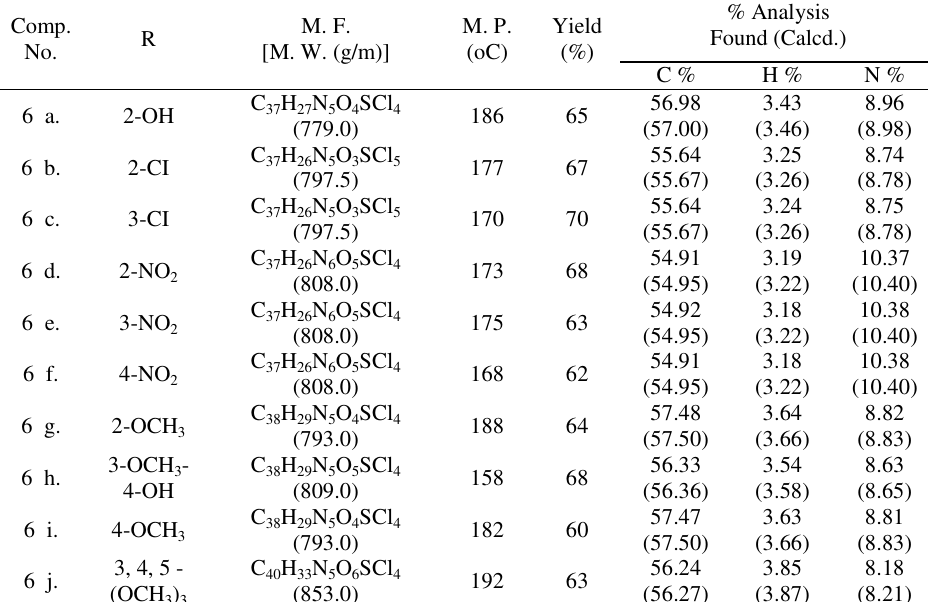
% Analysis Found (Calcd.)